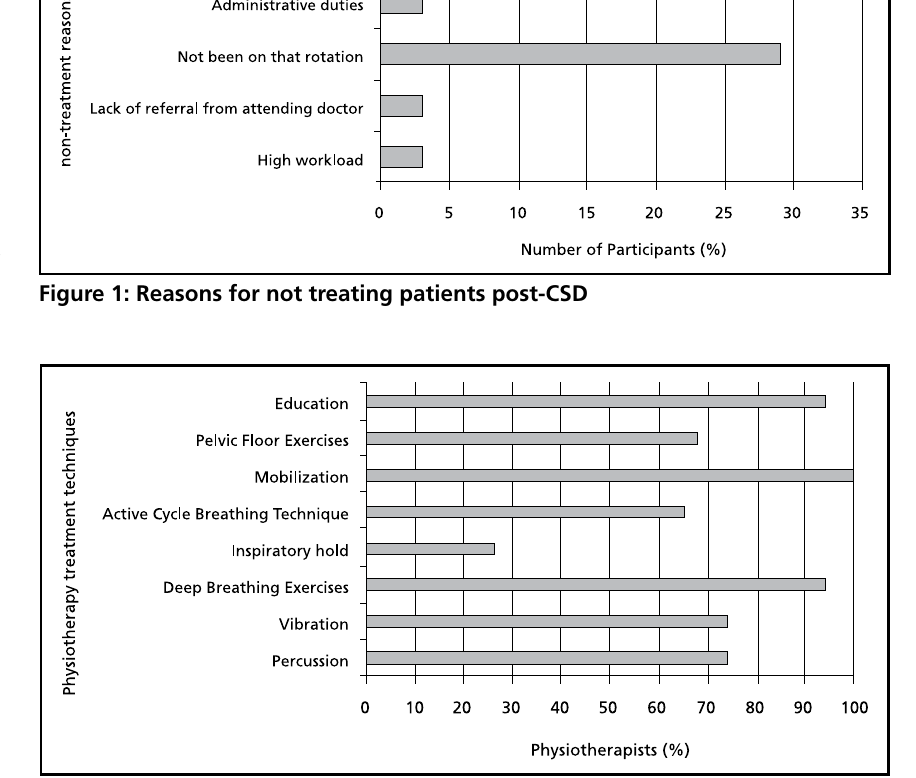
Figure 2: choice of physiotherapy treatment techniques for patients post-csD